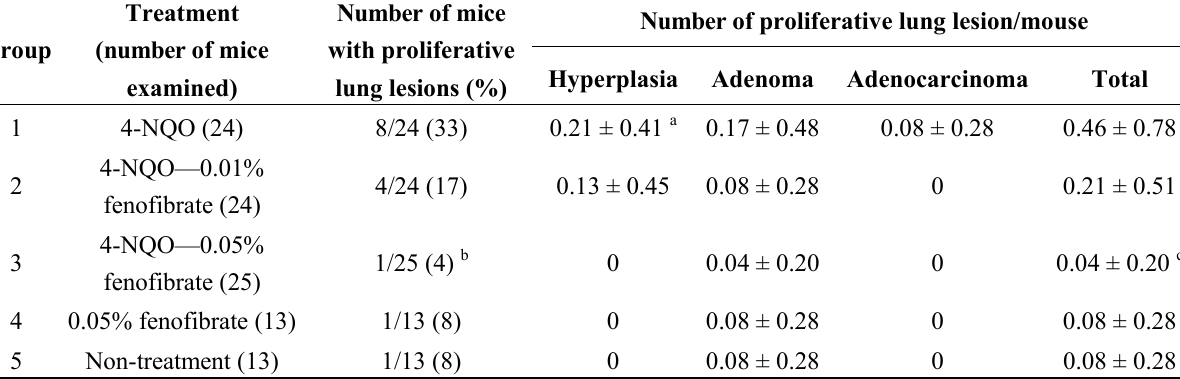
Table 1. Incidence and multiplicity (Number of lesions/mouse) of pulmonary proliferative